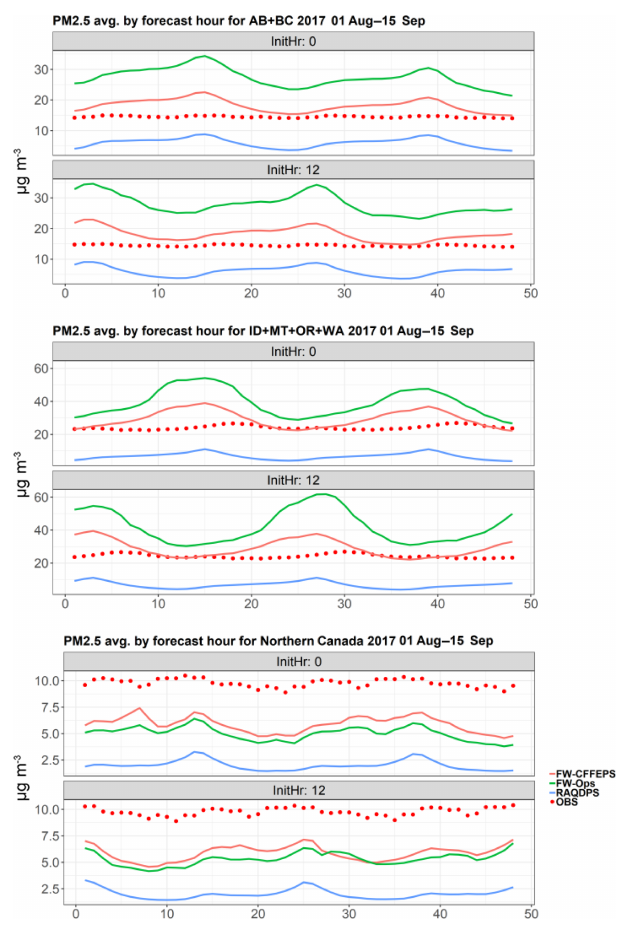
Figure 9. Mean PM 2 . 5 concentrations (µgm − 3 ) by forecast hour (f00–f48) for the period from 1 August to 16 September 2017 for the three forecast models and surface measurements (OBS) for AQ measurement stations in the AB + BC (top), ID + MT + OR + WA (centre), and northern Canada (bottom) regions. The forecasts launched at 00:00 and 12:00UTC are analysed